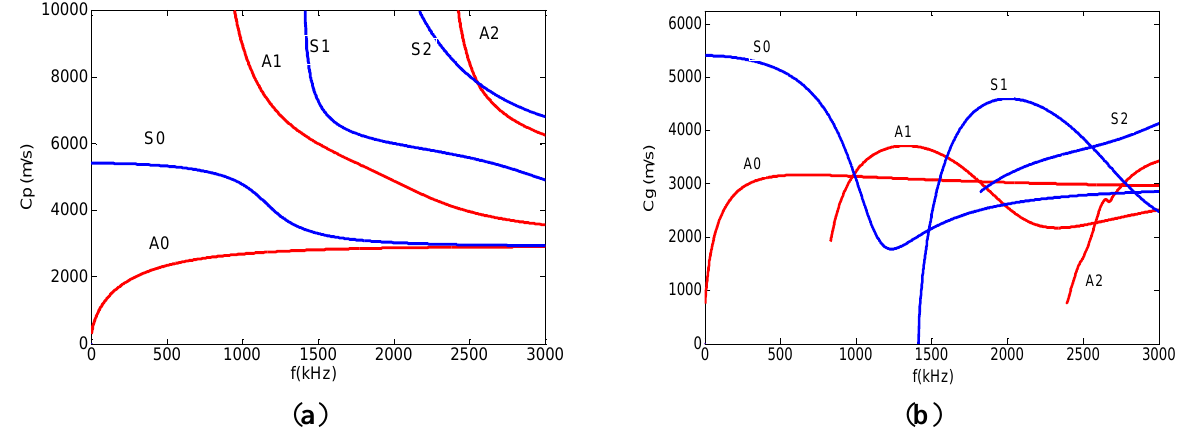
Figure 1. ( a ) Phase velocity dispersion curves for a 2 mm thick aluminum plate, Cp represents phase velocity. ( b ) Group velocity dispersion curves for a 2 mm thick aluminum plate, Cg represents group